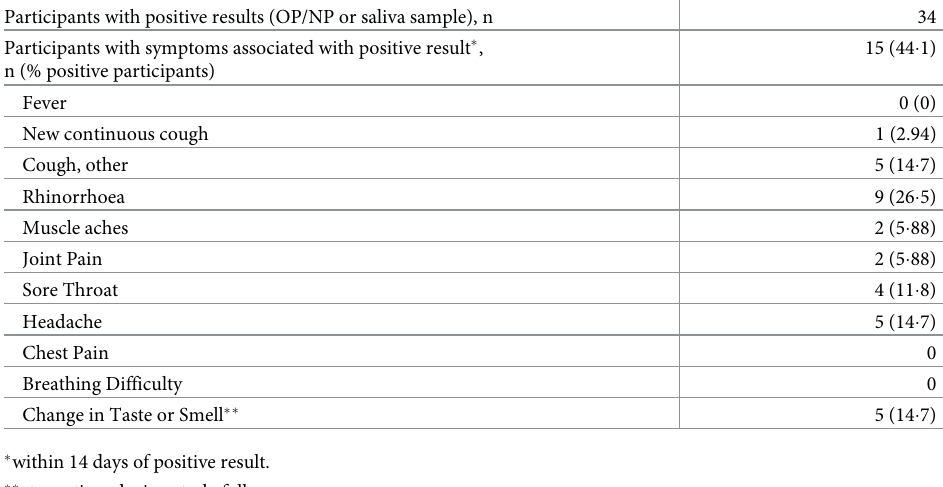
Table 2. Symptom reporting in SARS-CoV-2 RNA positive participants during study follow up. (Excluding partic- ipants who were self-isolating for COVID-19 case definition symptoms). Participants with positive results (OP/NP or saliva sample), n Participants with symptoms associated with positive result � , n (% positive